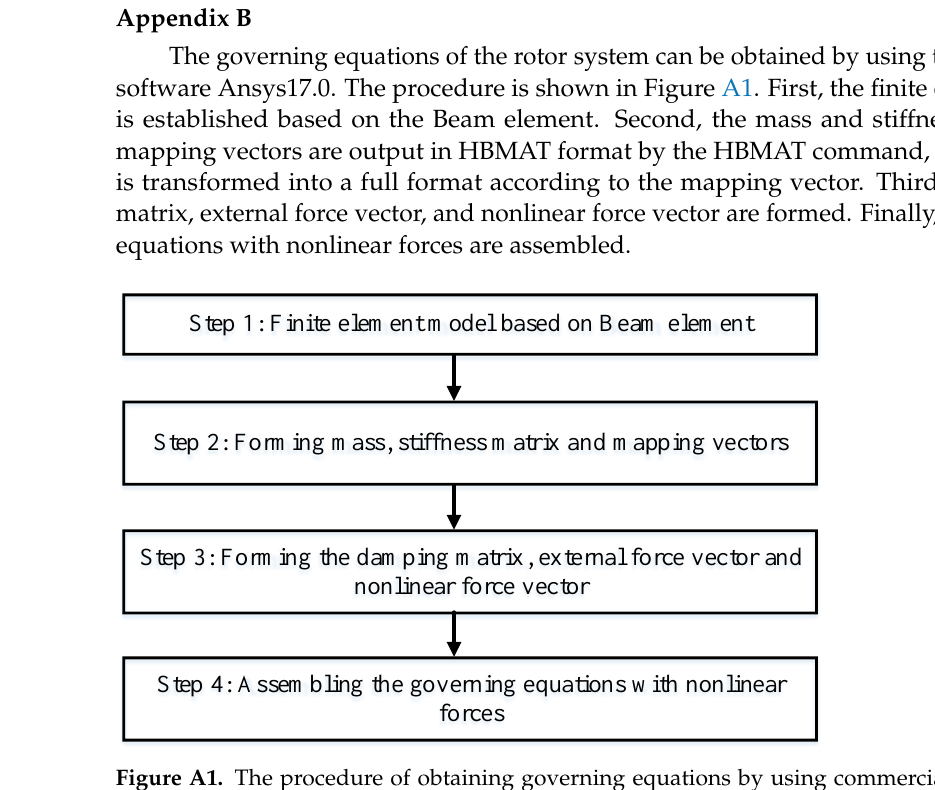
Figure A1. The procedure of obtaining governing equations by using commercial finite element software.